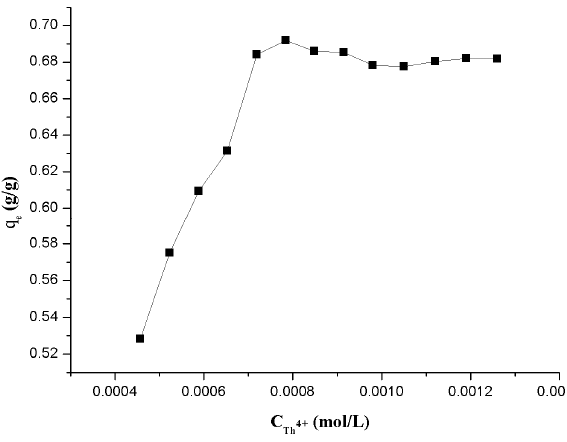
Figure 9. Effect of the initial concentration of Th 4+ on the adsorption behavior onto β -CD(AN- co -AA). ([pH = 2.95 ± 0.05, m/V = 0.18 g/L, T = 298.15 ± 1.00 K, I = 0.50 M NaNO 3